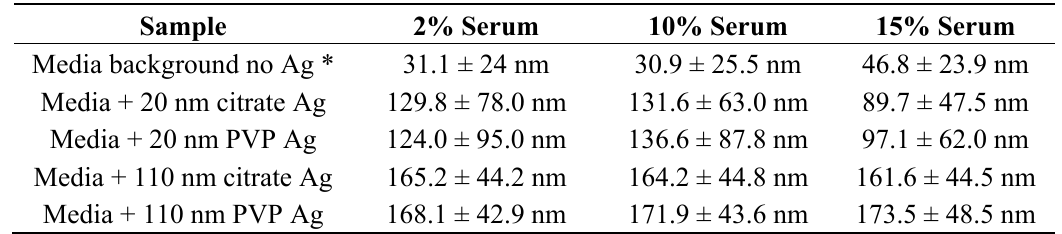
Figure 4. Uptake of Ag nanospheres by C57BL/6 and MARCO null AM illustrated using TEM imaging at 1.5 h post exposure. ( A ) No particle control C57BL/6 AM; ( B ) C57BL/6 AM exposed to 25 µg/mL 20 nm citrate-stabilized Ag nanospheres; ( C ) C57BL/6 AM exposed to 25 µg/mL 20 nm PVP-stabilized Ag nanospheres; ( D ) C57BL/6 AM exposed to 25 µg/mL 110 nm citrate-stabilized Ag nanospheres; ( E ) C57BL/6 AM exposed to 25 µg/mL 110